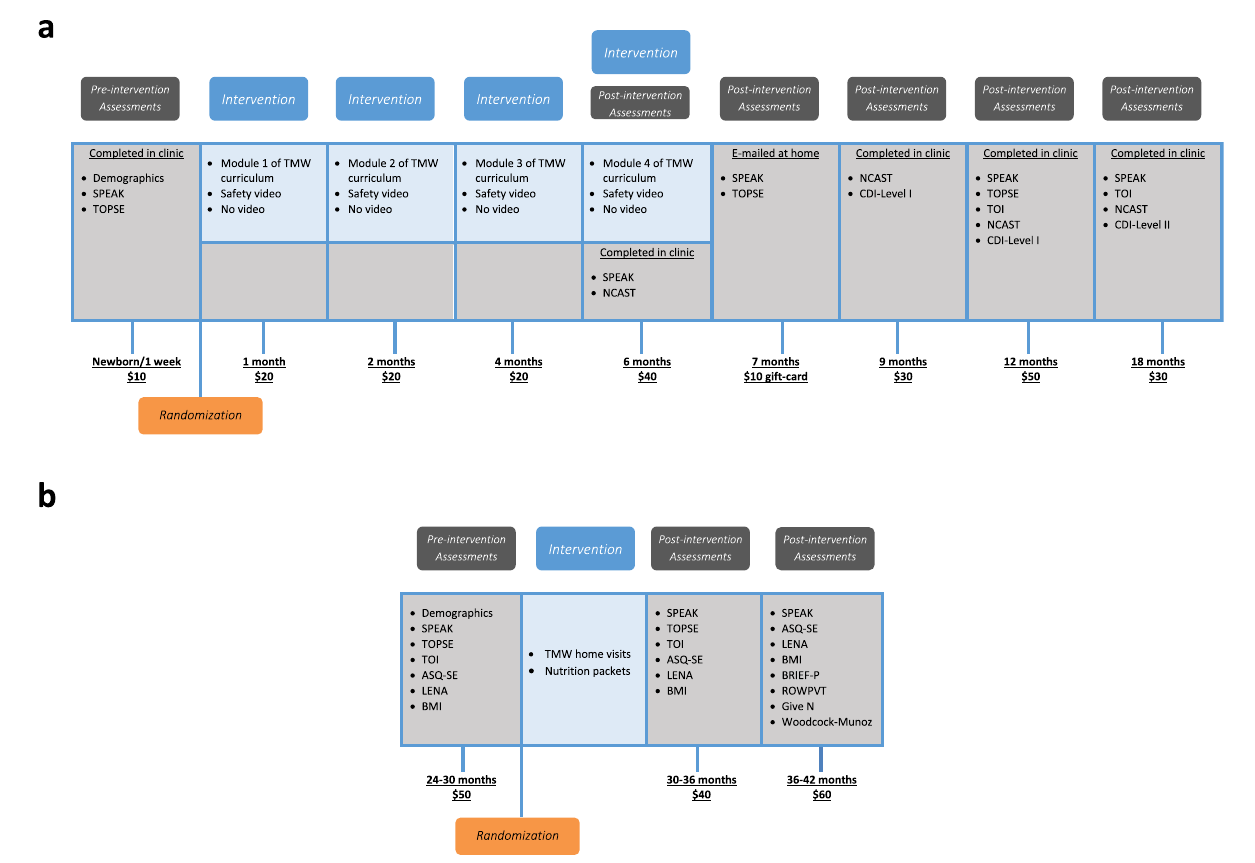
Fig. 2 Timeline of the studies with the surveys used. a Newborn study. b Home-visiting